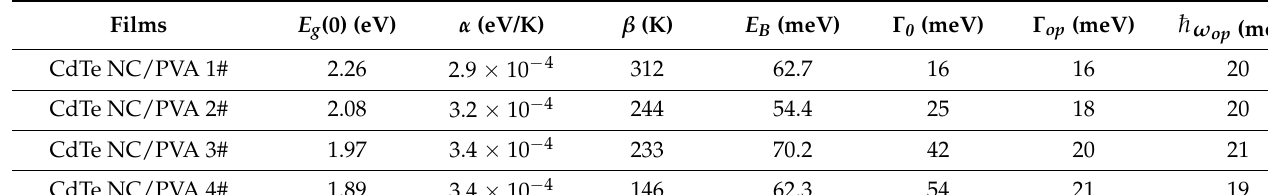
Table 1. Fitted parameters in terms of Equations (1)–(3).